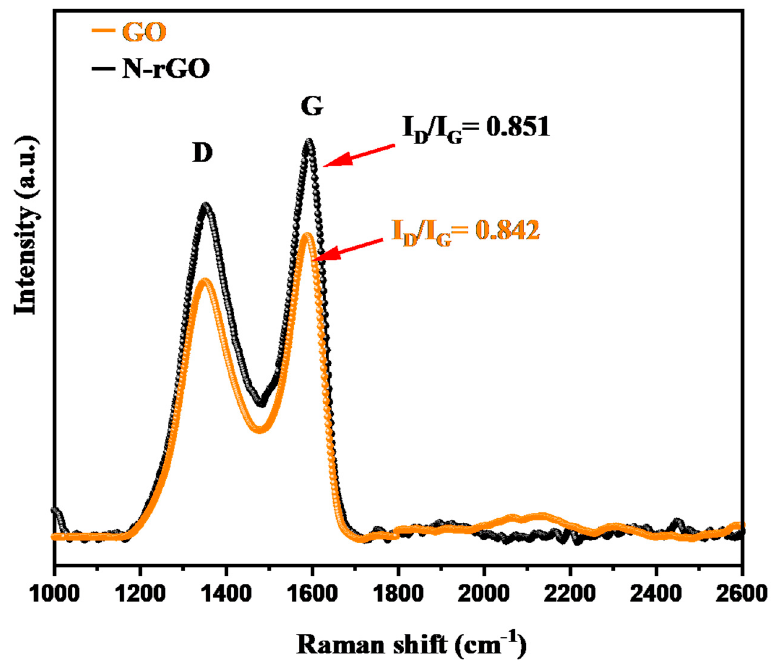
Figure 3. The Raman spectra of GO and N-rGO.